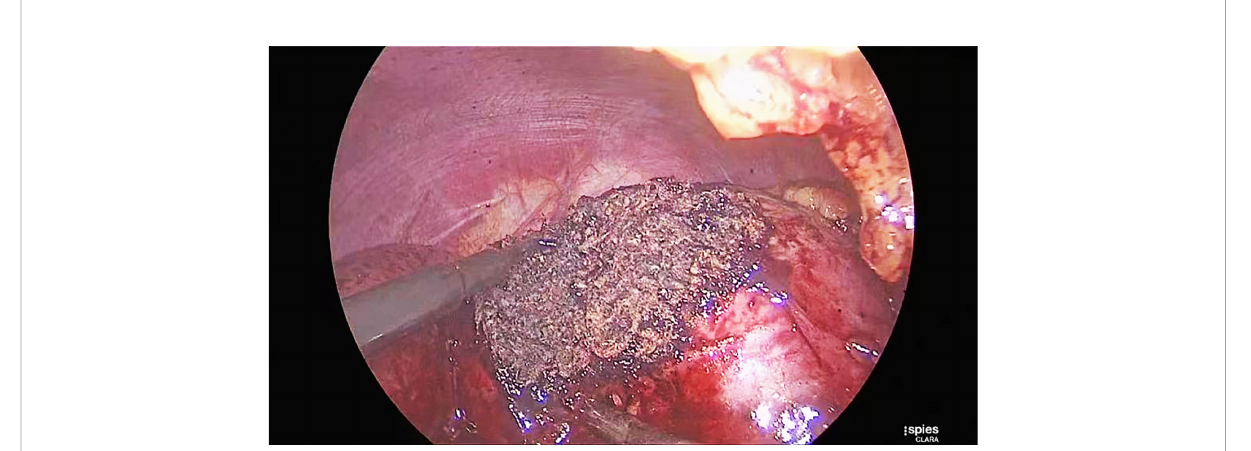
FIGURE 2 Repeated coagulation to form a helmet-like eschar helped maintain